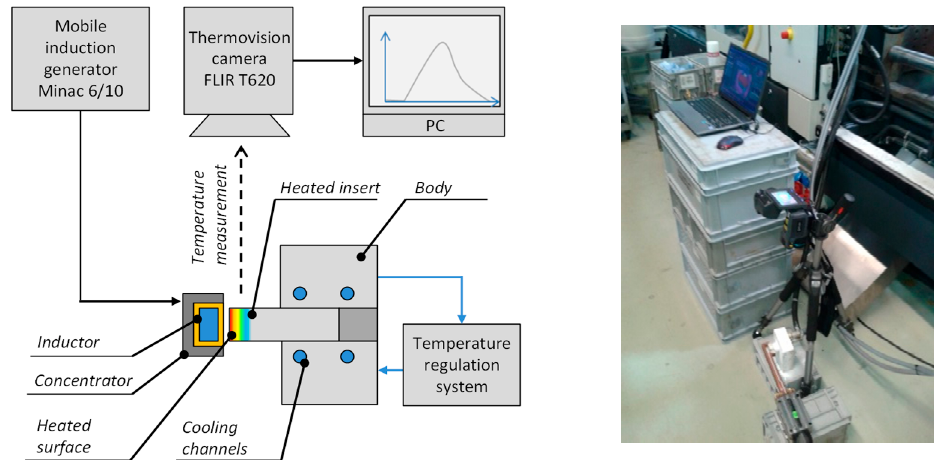
Figure 3. The experimental validation setup.